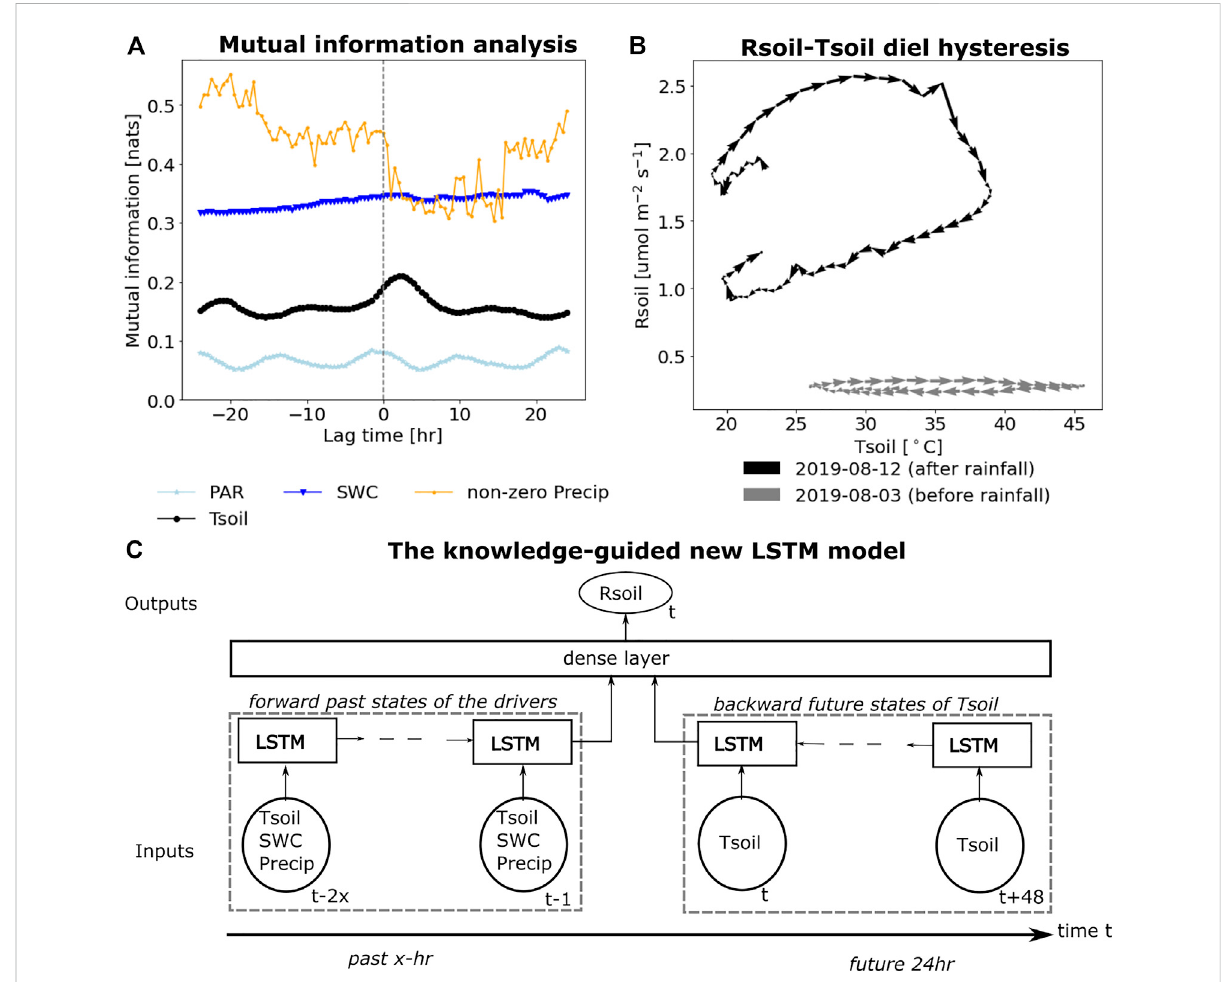
FIGURE 2 Knowledge-guided deep learning (DL) for predicting soil respiration (Rsoil) using mutual information analysis. (A) the quanti fi ed mutual information between Rsoil and each of the lagged environmental drivers: non-zero precipitation (Precip), photosynthetic active radiation (PAR), soil temperature (Tsoil), and soil water content (SWC). Positive (negative) time lag represent lagging behind (before) Rsoil. (B) two clockwise diel hysteresis events between Rsoil and Tsoil on two summer days separated by a rainfall event. (C) the new LSTM model for estimating Rsoil that takes past states of Tsoil, SWC, and Precip as well as 24 future hrs of Tsoil as